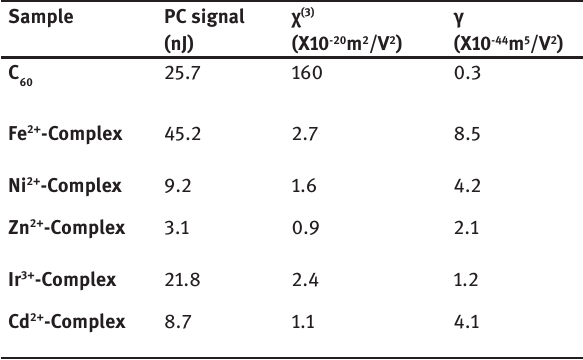
Table 3: Results of third order NLO